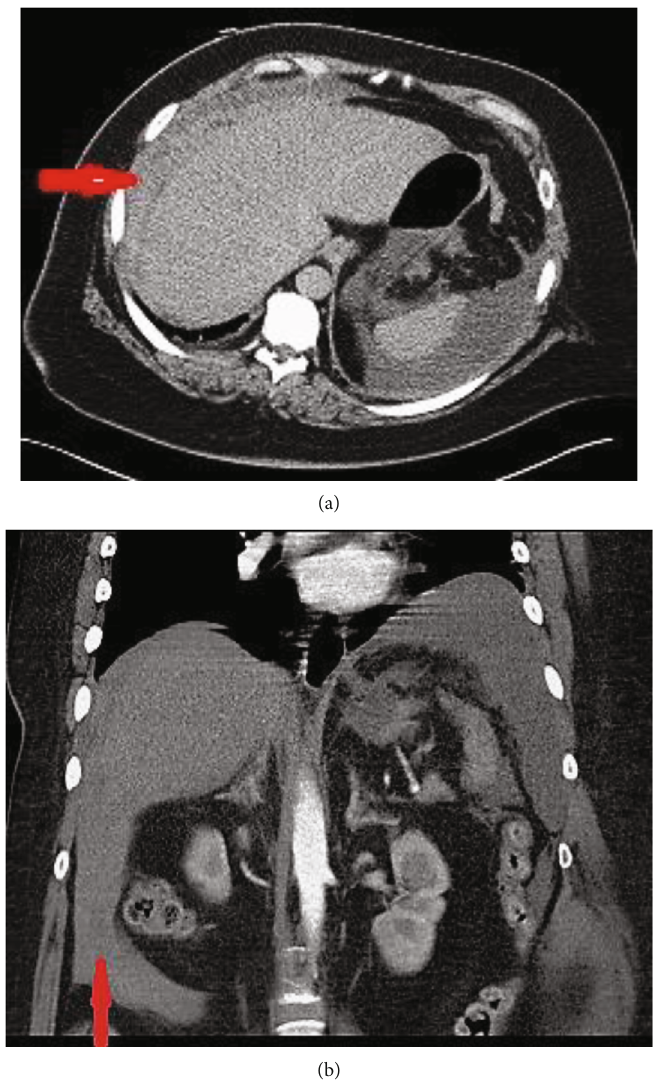
Figure 1: (a) Axial postcontrast CT image demonstrating acute subcapsular haematoma surrounding the lateral surface of the right lobe of liver (red arrow). (b) Coronal postcontrast CT image demonstrating ruptured subcapsular haematoma with fresh blood extending to the right paracolic gutter (vertical arrow points to a hyperdense material inferior to the